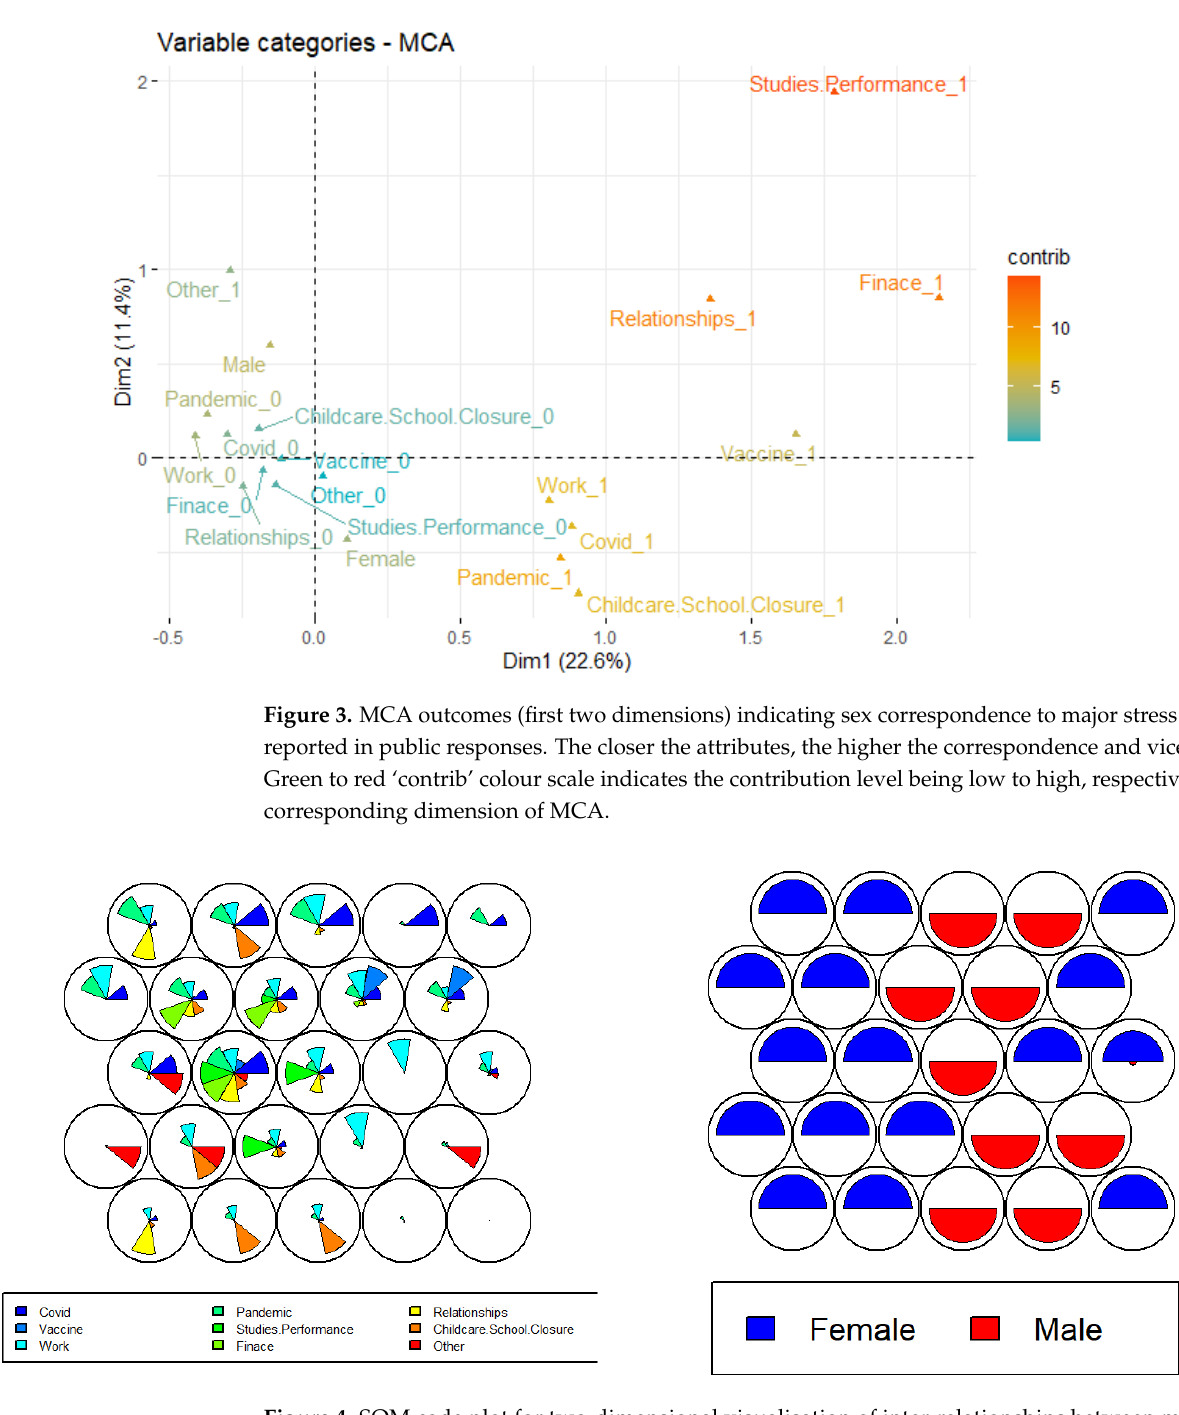
Figure 4. SOM code plot for two-dimensional visualisation of inter-relationships between multiple causes of mental stress ( left side plot) within the dataset and participants’ sex ( right side plot).